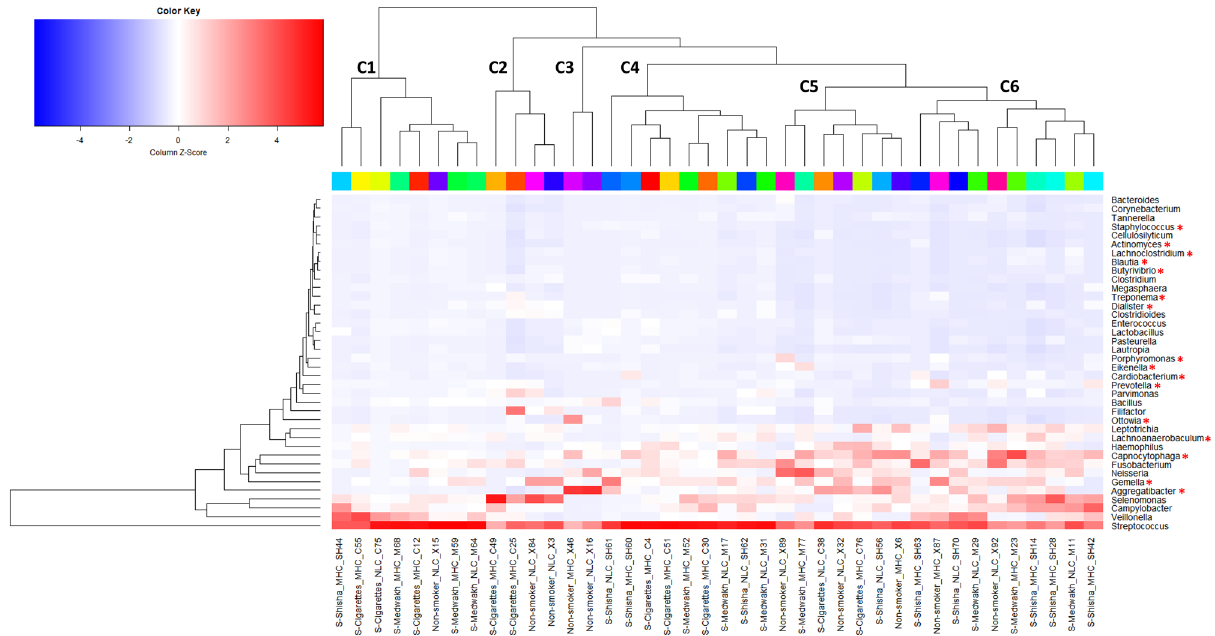
color indicates low abundance of each bacterial genera. Dendrograms show clustering based on the relative abundance of different genera (left dendrogram: genera clustering; top dendrogram: clustering of samples